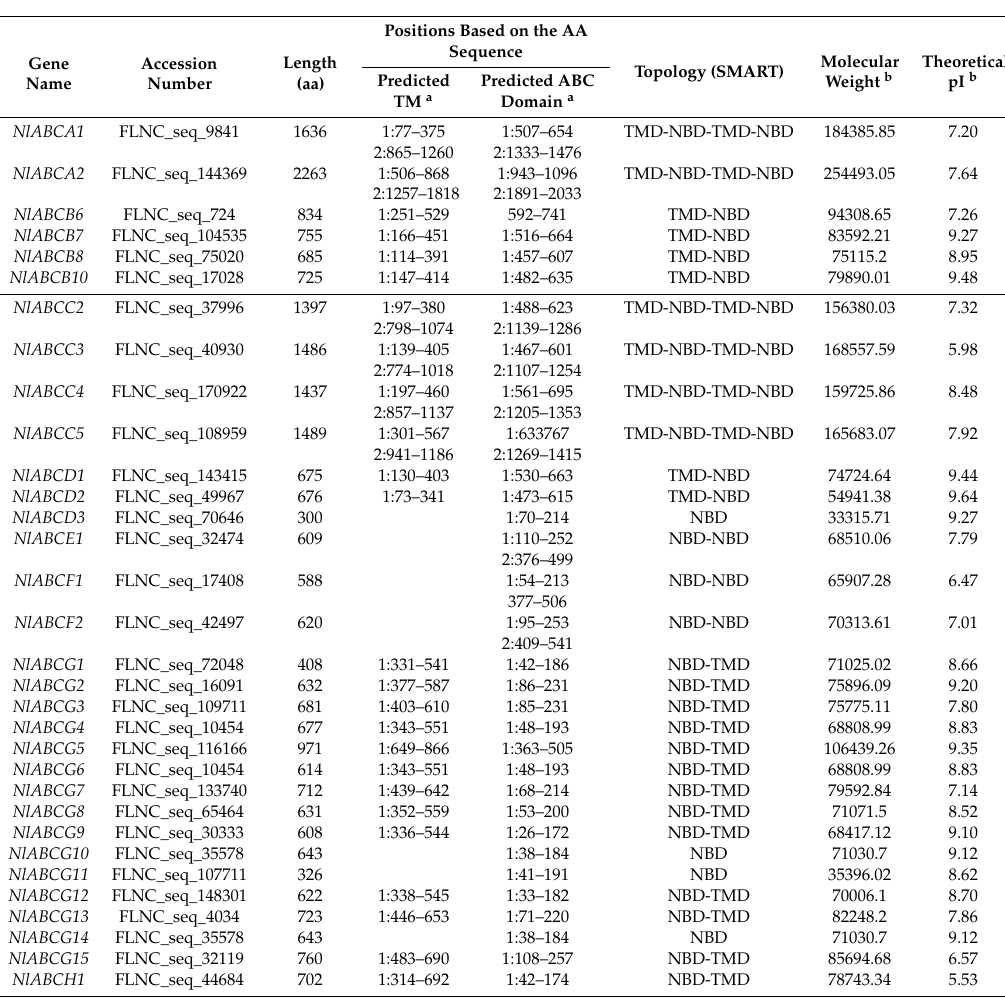
Table 1. Details on the 32 ABC transporters identified in Nilaparvata lugens